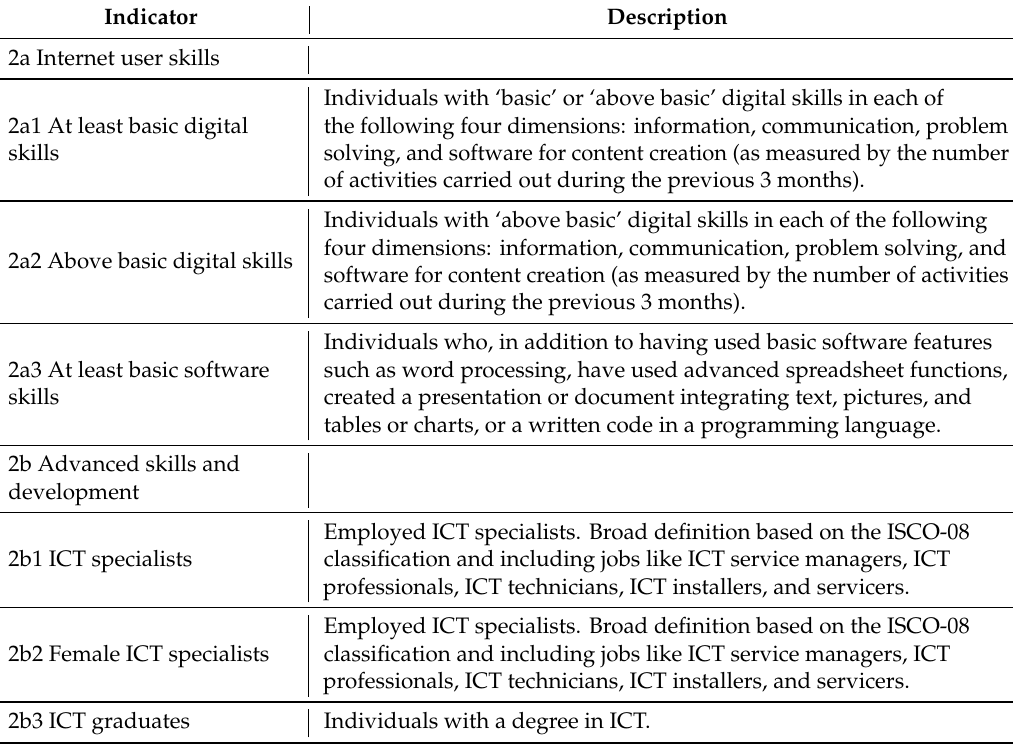
Table 2. A Human Capital Dimension in the DESI Structure.